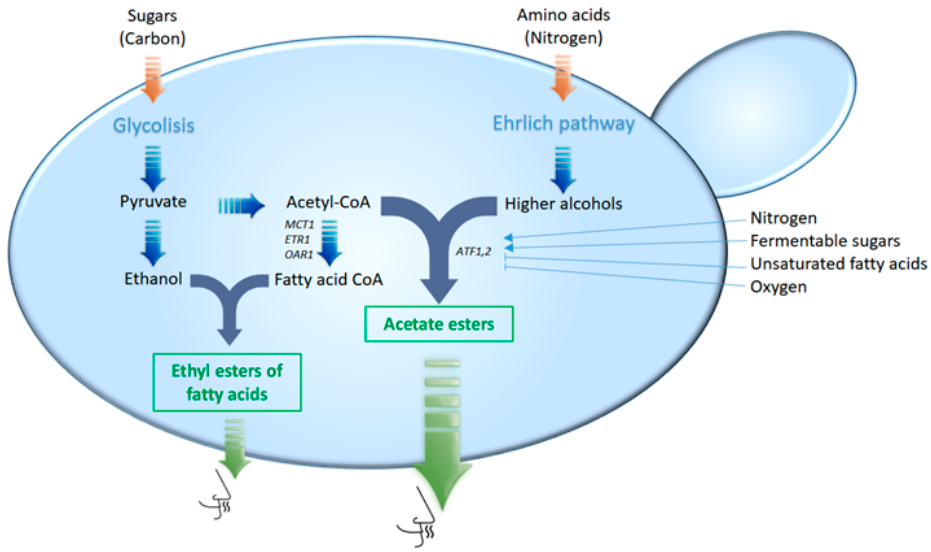
Figure 3. Simplified metabolic map of ester formation. Genes that codify enzymes involved in ester formation are indicated. The substrate availability depends mainly on carbon, nitrogen, and fatty acid metabolism, while the ester synthase activity is mainly determined by the activity of the corresponding genes. Thus, factors that affect yeast metabolism or ester synthase gene regulation will influence ester synthesis.